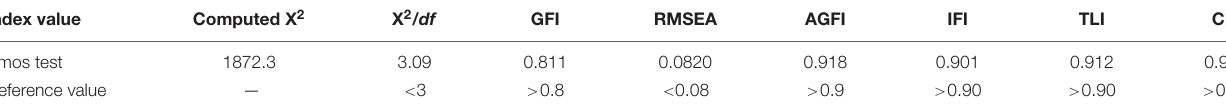
TABLE 7 | Tests of goodness fit for the structural equations.